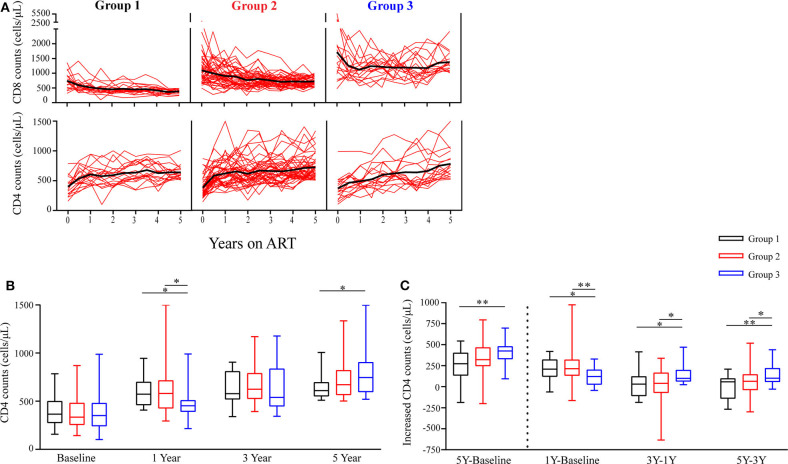
Longitudinal changes in CD4 counts and CD8 counts during ART. (A) Time trajectories of CD8 counts and CD4 counts over 5 years in participants receiving ART. Individual trajectories are shown with red lines, mean values are indicated by thick black lines. (B) Statistical analysis of CD4 counts in the three groups at baseline, years 1, 3, and 5 on ART. (C) Comparisons of increased CD4 counts from three different groups are assessed from baseline to year 5, from baseline to year 1, from years 1 to 3, and from years 3 to 5. Group 1 (G1, n = 18 participants), Group 2 (G2, n = 45 participants), Group 3 (G3, n = 18 participants). In (B,C), boxes show median and IQR, and whiskers are minimum and maximum. *P < 0.05, **P < 0.01.